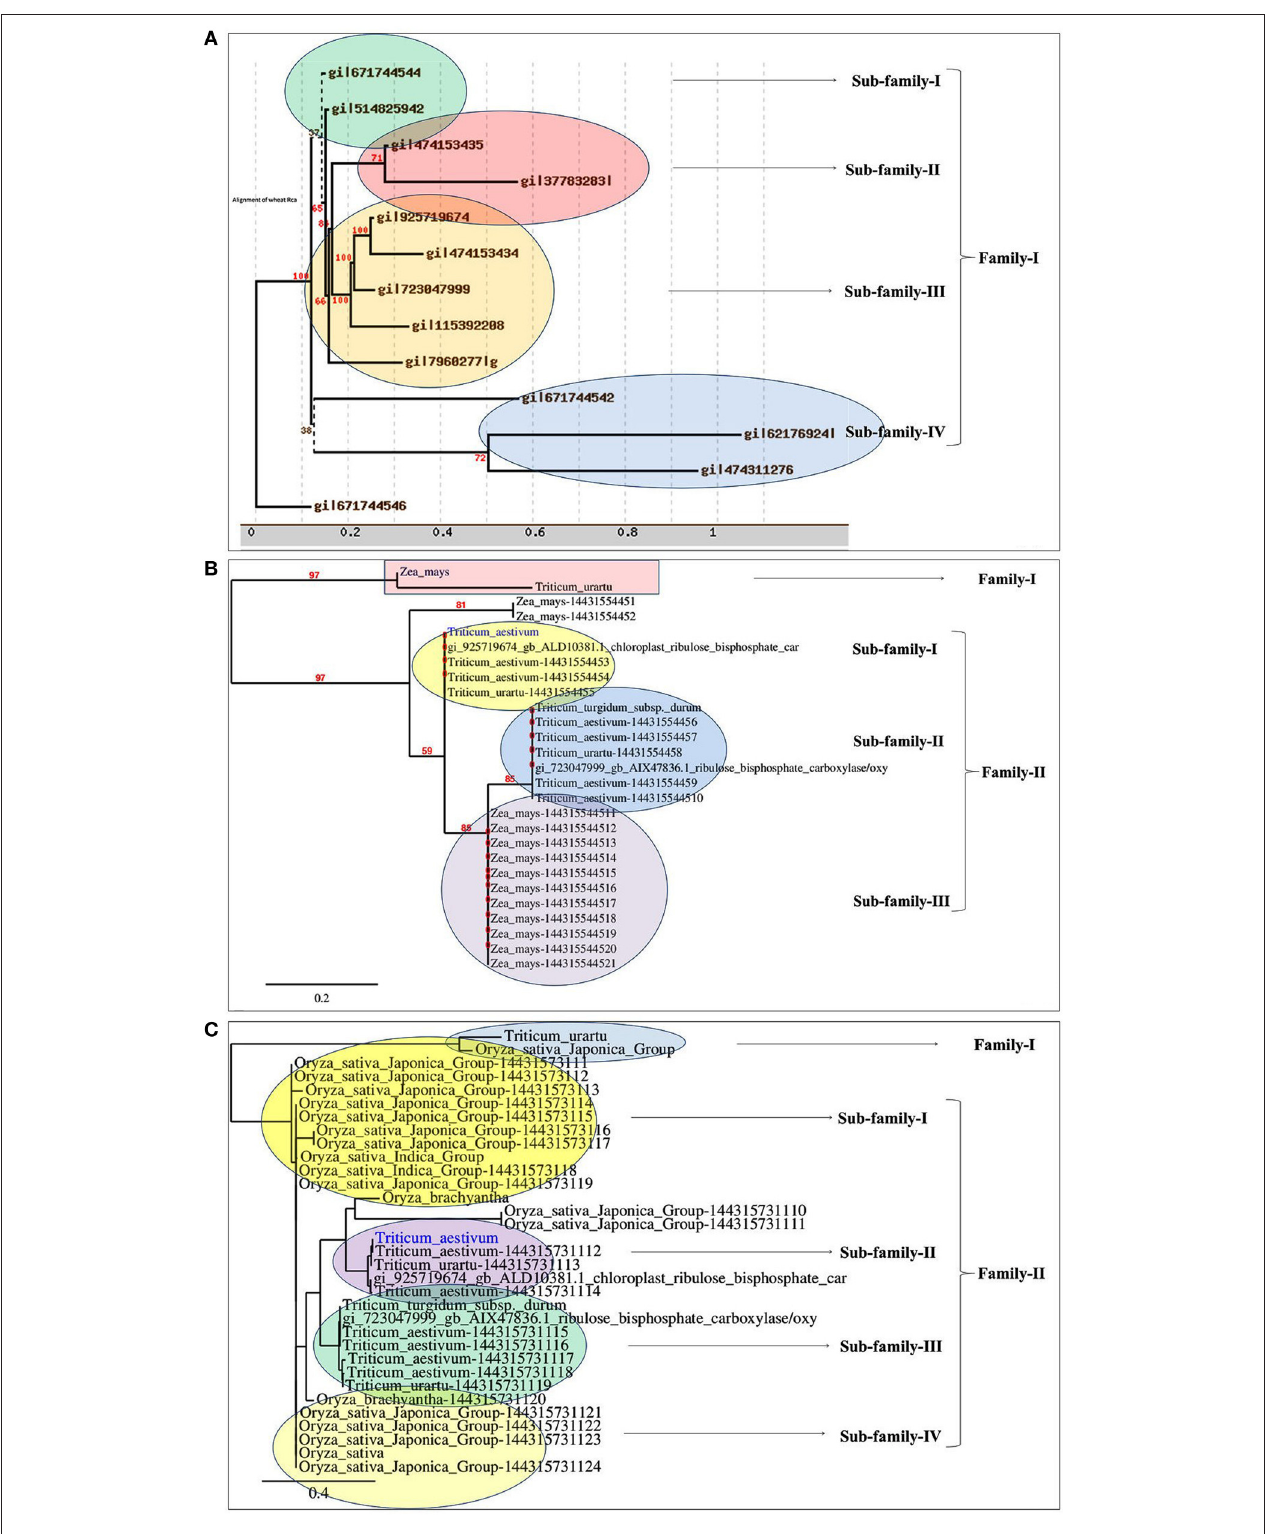
FIGURE 1 | Phylogenetic analysis of RuBisCo activase gene ( TaRca1 ) cloned from wheat cv . HD2985. (A) Classification of TaRca1 based on RuBisCo activase reported from other plant and non-plant sources, (B) Classification based on Rca reported from Zea mays ; (C) Classification based on Rca reported from Oryza sativa